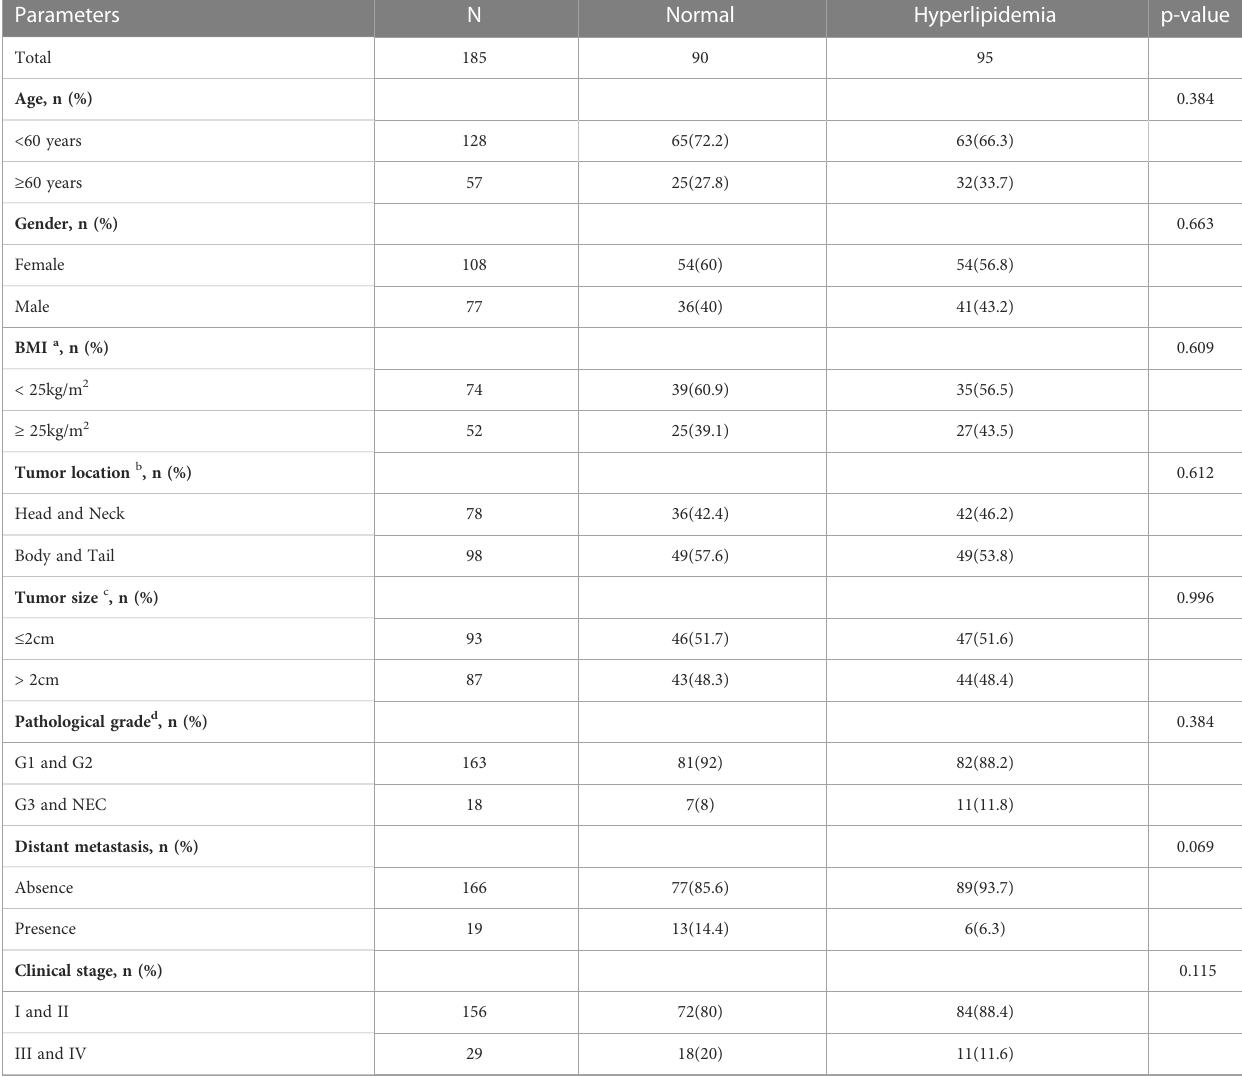
TABLE 2 Comparison of clinicopathological parameters in PanNENs patients with normal or hyperlipidemia. Parameters N Normal Hyperlipidemia